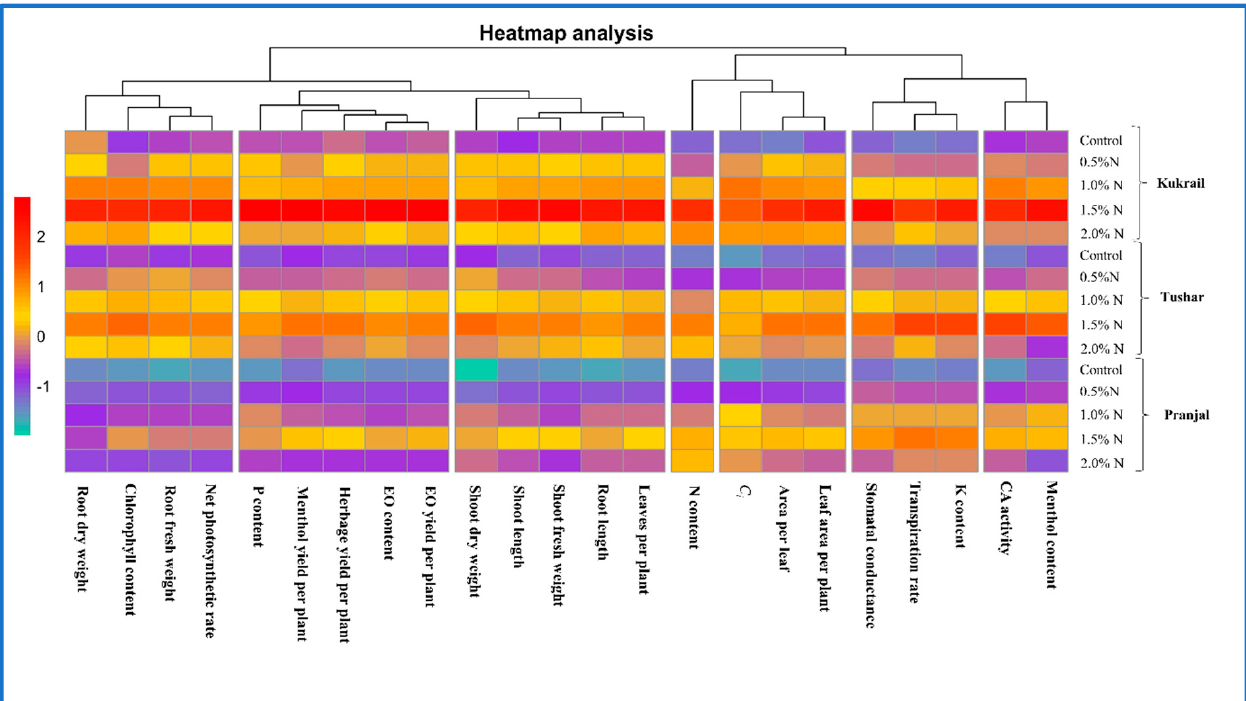
Figure 15. Heat map analysis of the studied parameters of three cultivars of peppermint.